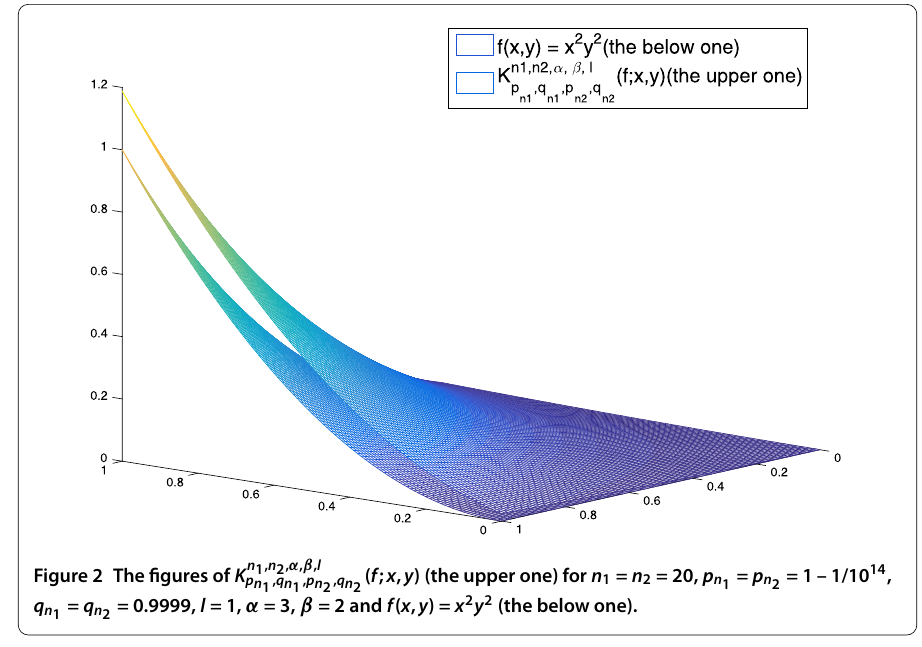
Figure 2 The figures of K n 1, n 2, α , β , l pn 1, qn 1, pn 2, qn